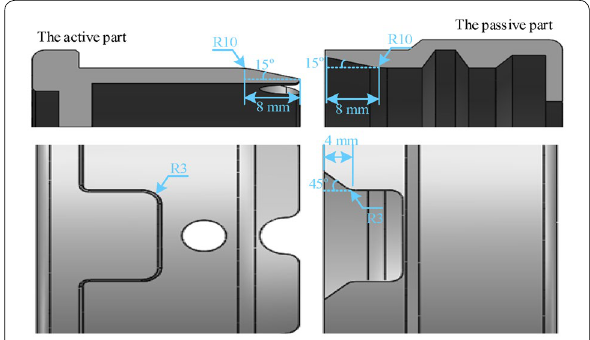
Figure 5 Tolerance designs of the RCM based on SMA